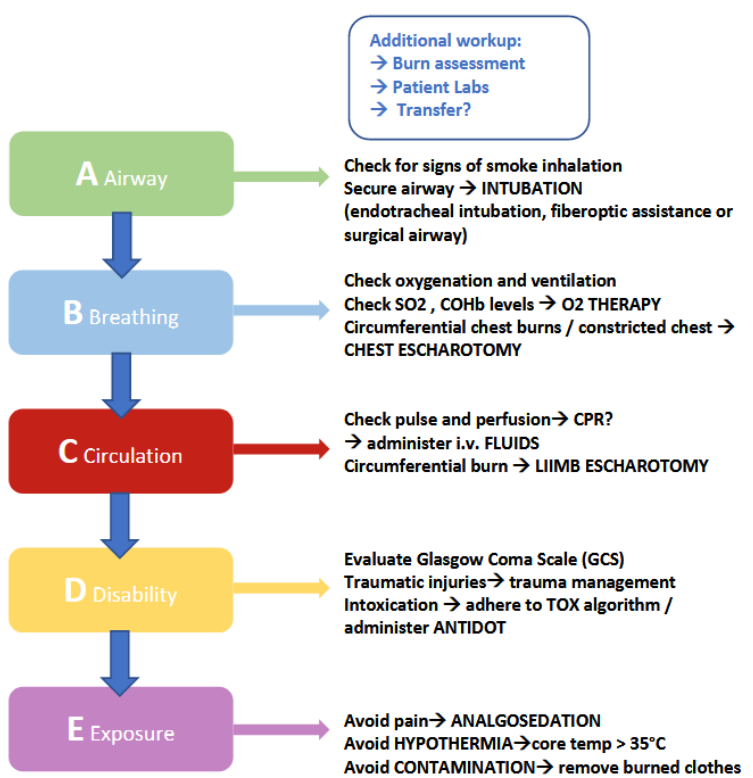
Figure 1. Burn algorithm: Simplified schematic display of important steps in burn management. This table raises no claim to completeness. Although this is an original graphic created for this publication, similarities to existing figures may apply.